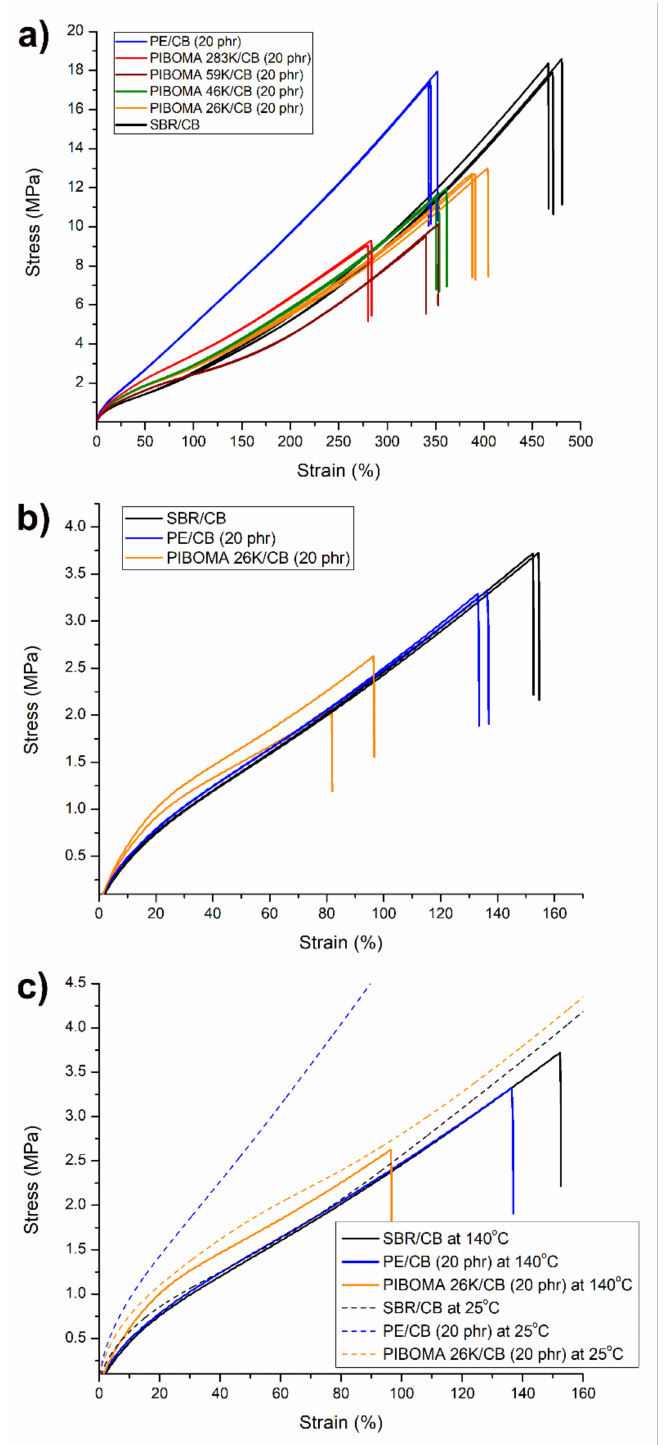
Figure 7. Stress–strain curves of vulcanized rubber compounds containing 50 phr of CB and filled either with 20 phr of PIBOMA having various molecular weights or with 20 phr of UHMWPE (at 25 ( a ) and 140 ◦ C ( b )). Overlaying of the stress-strain curves at 25 and 140 ◦ C ( c